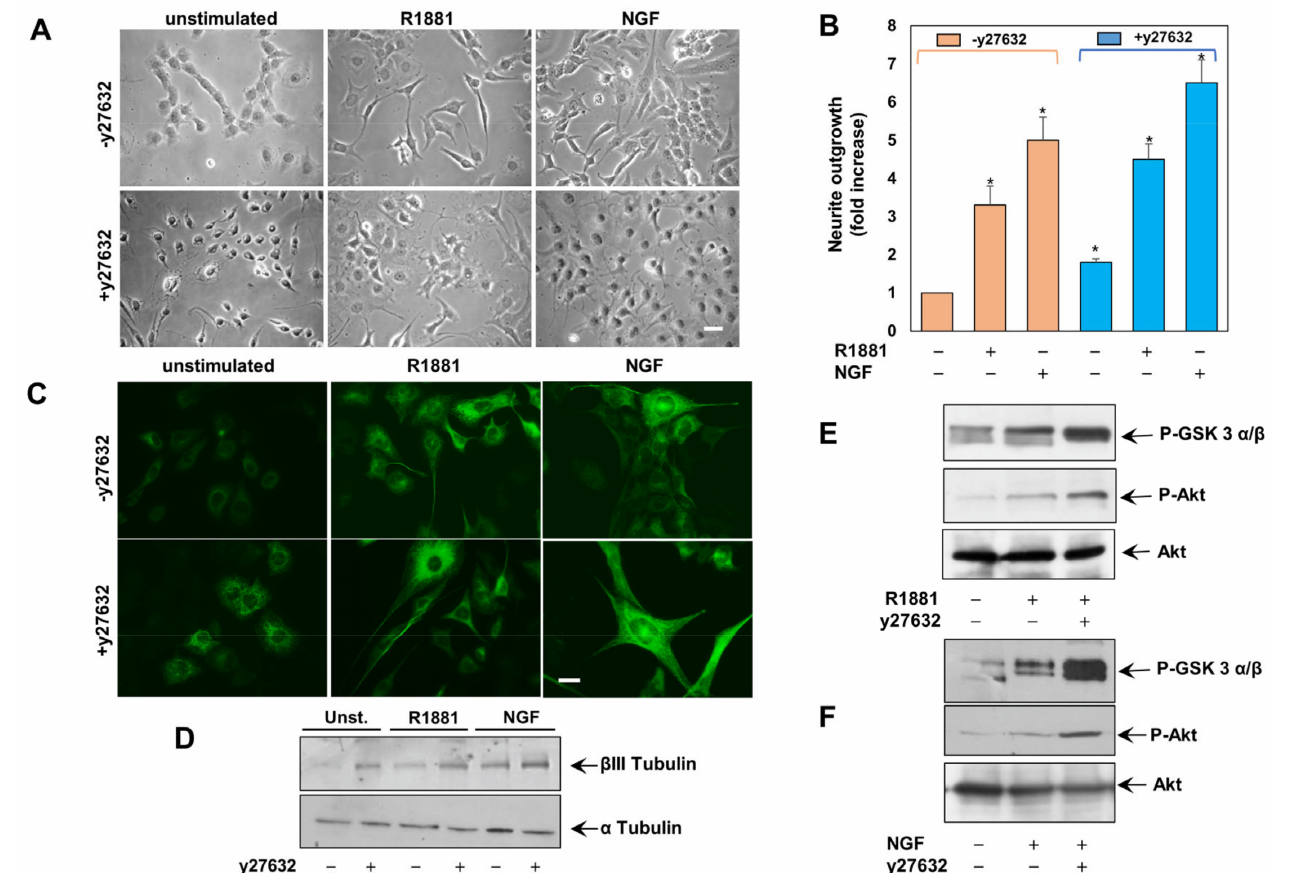
Figure 3. ROCK inhibition increases the R1881- and NGF-neurite elongation. ( A ), PC12 cells were un- treated or treated for 24 h with R1881 or NGF in absence or presence of y27632 and neurite outgrowth was analyzed ( B ). ( B ), the difference in neurite outgrowth was expressed as fold increase over the basal levels. * p < 0.05 for the indicated experimental points vs the corresponding unstimulated cells, as well as for the unstimulated, R1881- or NGF-stimulated cell pairs, in the absence or presence of y27632. Means and SEMs are shown. n indicates the number of experiments. Cells were left untreated or treated as in A and analyzed by IF ( C ) or by WB ( D ) for tubulin β -III. In ( A , C ), Bar, 10 µ M. In ( E , F ), lysates proteins were analyzed by WB, using the antibodies against the indicated